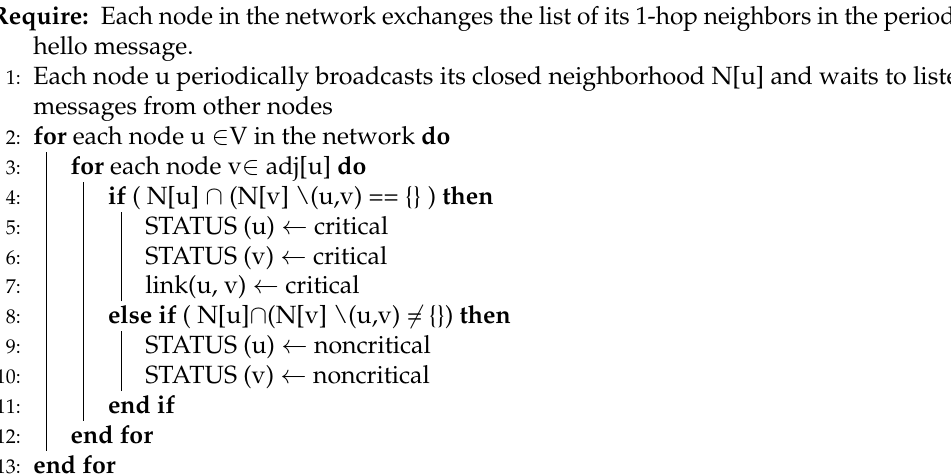
Algorithm 1 Critical node/link